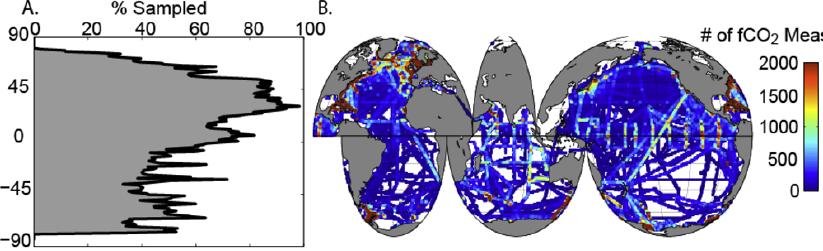
Figure 4. (A) The percentage of ocean grid cells that have been sampled for each latitude band and (B) map showing total number of observations in each grid cell over the full time period of the data set (1970–2007). White spaces indicate no data.